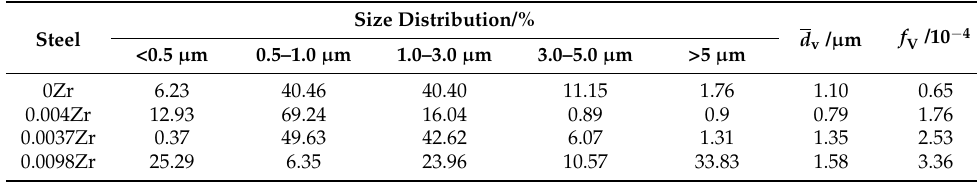
Table 3. Statistical results of inclusions in